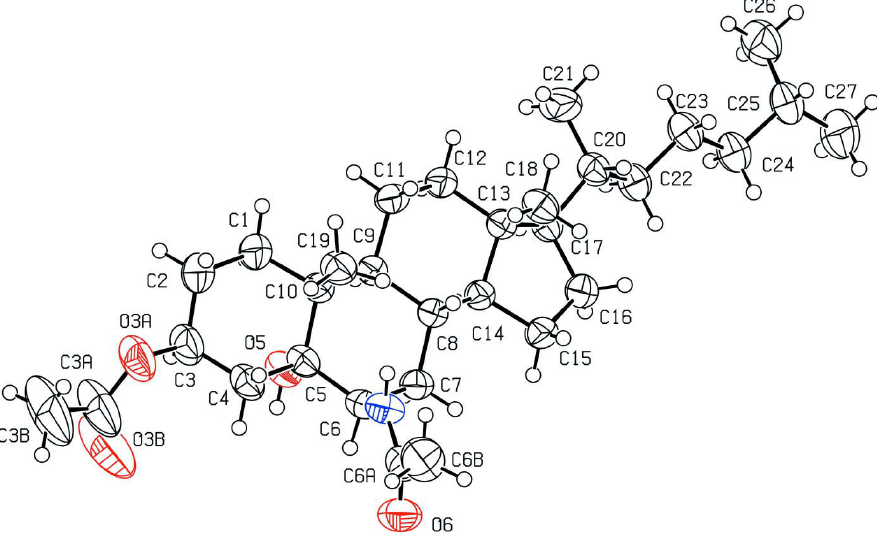
Molecular structure of the title compound. Displacement ellipsoids are drawn at the 50% probability